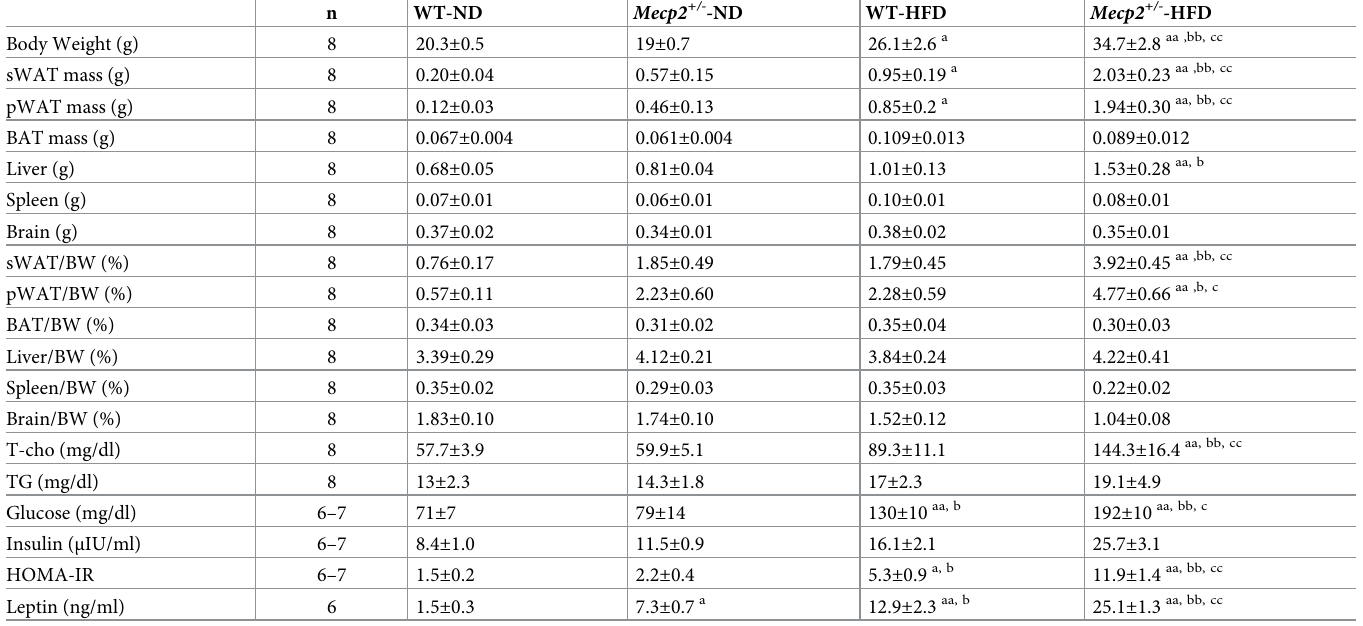
Table 1. Organ weights and metabolic